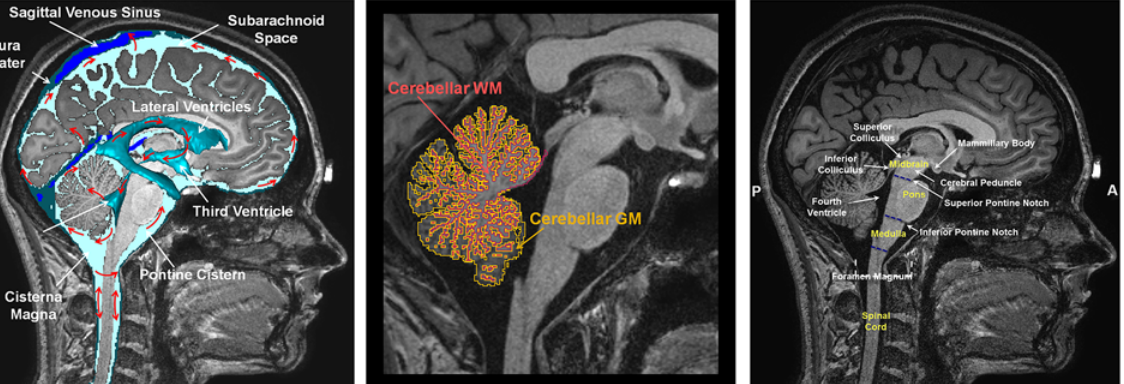
Fig 12. Segmentation of the brainstem, cerebellum, and CSF. Mid-coronal slice of the T1-weighted MRI (left) showing the CSF circulation (red arrows). Magnified view of the mid-coronal slice of the cerebellum (middle), showing the segmentation of the cerebellar GM (yellow) and WM (red). Mid-coronal slice of the brainstem and spinal cord (right), showing the landmarks used to subdivide the brainstem into its constituent substructures, i.e., the midbrain, pons, and medulla, and to separate the brainstem from the spinal cord.